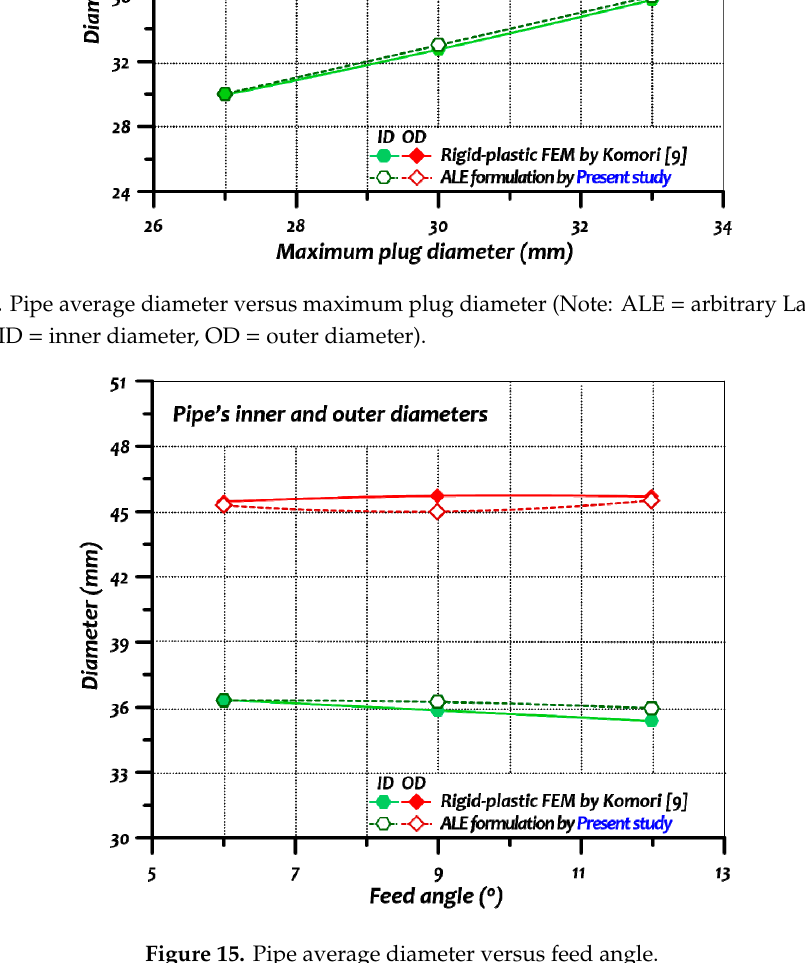
Figure 15. Pipe average diameter versus feed angle.